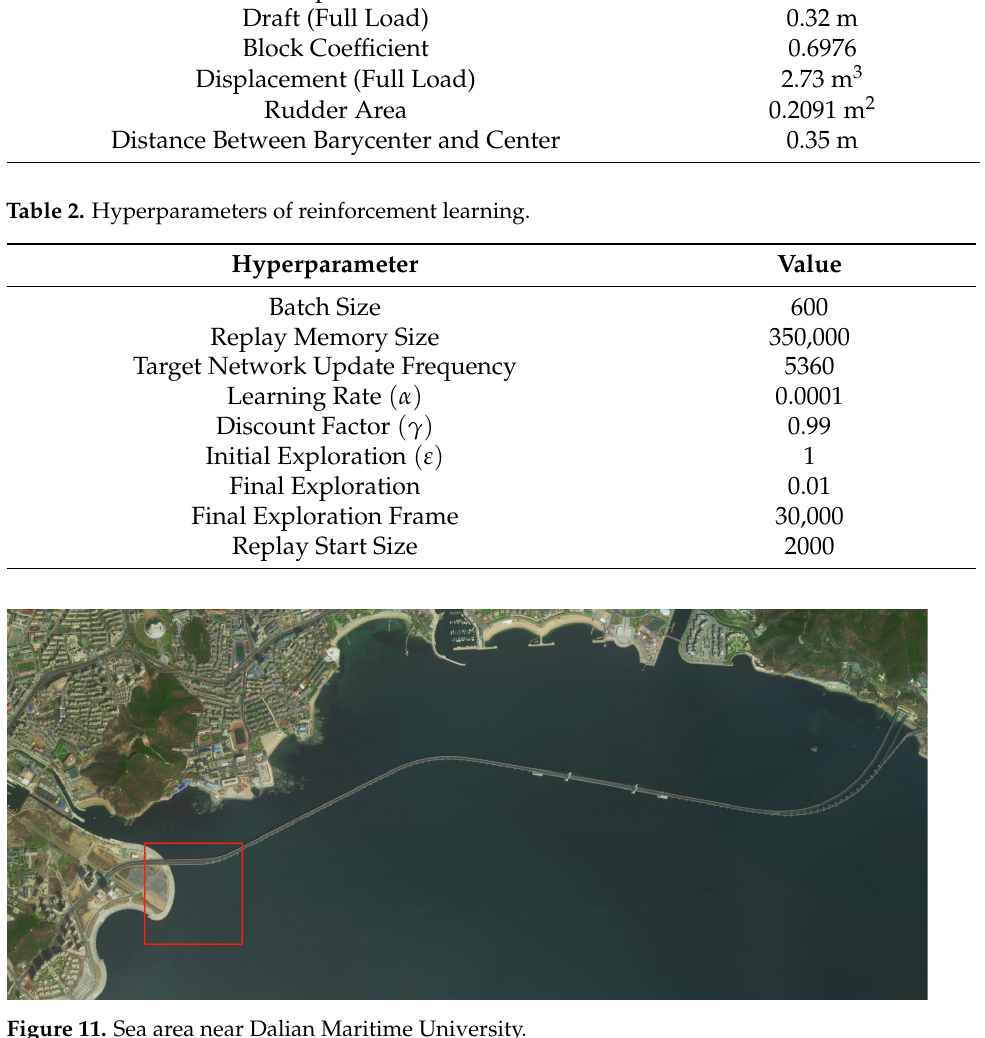
Figure 11. Sea area near Dalian Maritime